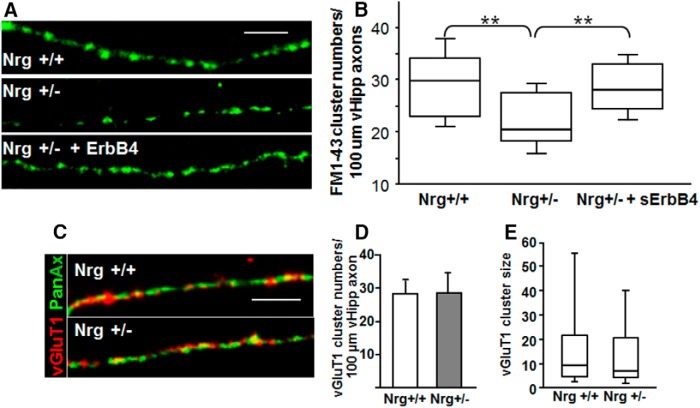
ErbB4-induced back-signaling rescues presynaptic phenotype of type III Nrg+/− vHipp axons. A, Representative micrographs of Nrg+/+ (top), Nrg+/− (middle) and Nrg+/− with 24 h of treatment of soluble ErbB4 (bottom) vHipp axons loaded with FM1-43 (green) to visualize sites of vesicle clusters (scale bar, 10μm). B, Box plot of pooled data shows a significant decrease in the number of FM1-43-stained clusters along axons from Nrg+/− compared with Nrg+/+ vhipp axons. Following 24 h of treatment of Nrg+/− axons with 2 ng/ml soluble ErbB4-ECD, the number of FM1-43-stained clusters along Nrg+/− axons was rescued to Nrg +/+ levels; **p < 0.01. C, Representative micrographs of Nrg+/+ (top), Nrg+/− (bottom) vHipp axons stained with antibodies recognizing vGluT1 (red), and a pan axonal marker (green) are shown. Scale bar, 10μm. D, Quantification of vGluT1 cluster numbers along vHipp axons from Nrg+/+ (28 ± 4 per 100 μm) or Nrg+/− (28.5 ± 5.5 per 100 μm) shows that there is no significant difference between conditions. E, Box plot of pooled data shows no significant difference in the size of vGluT1 clusters along axons from Nrg+/− compared with Nrg+/+.